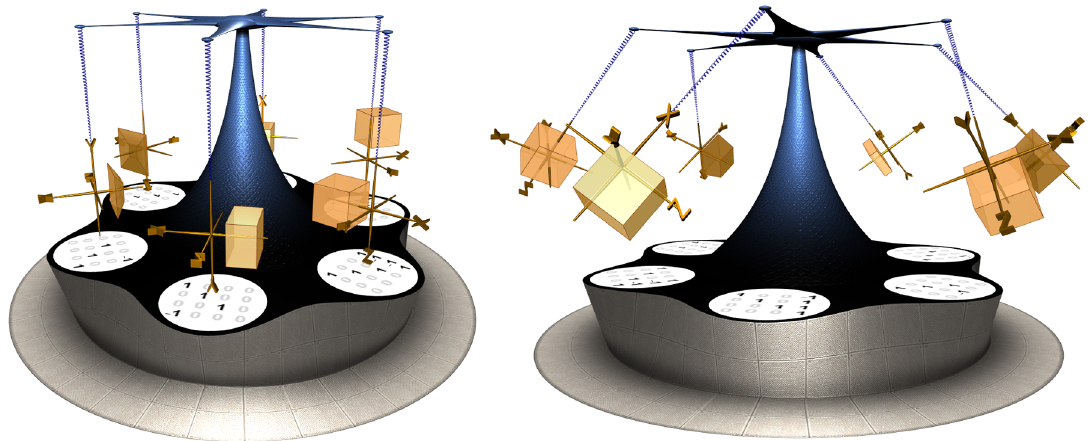
Figure 14. Snapshots of the Matrix carousel.